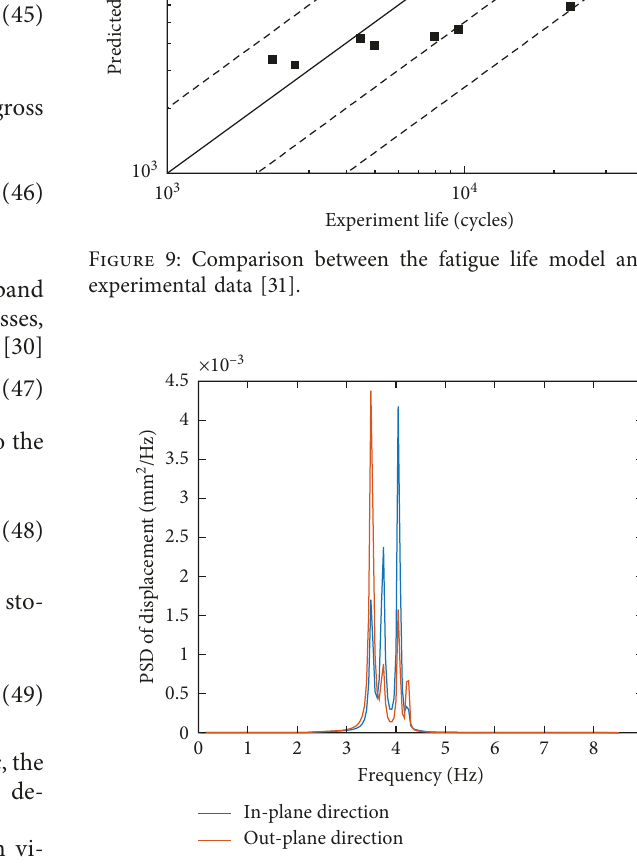
Figure 10: PSD of the displacement at the fuel rod